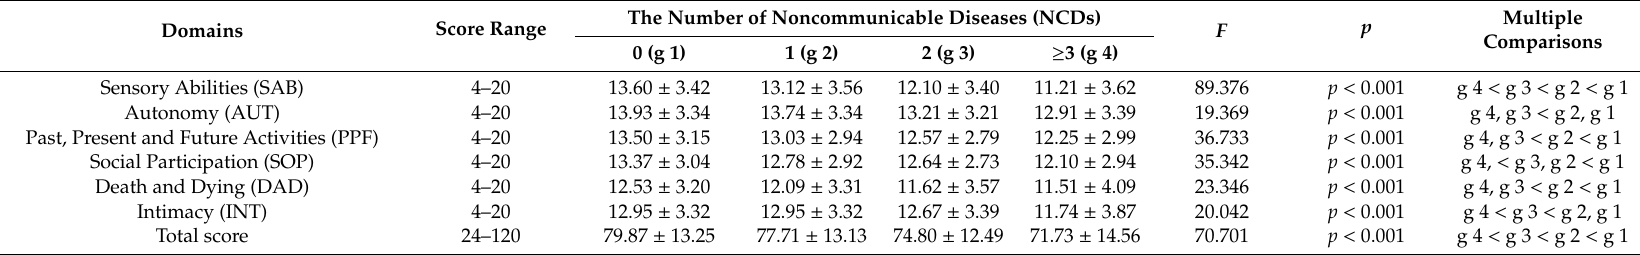
Table 2. Scores of World Health Organization Quality of Life-Old (WHOQOL-OLD) among the population with di ff erent numbers of NCDs.